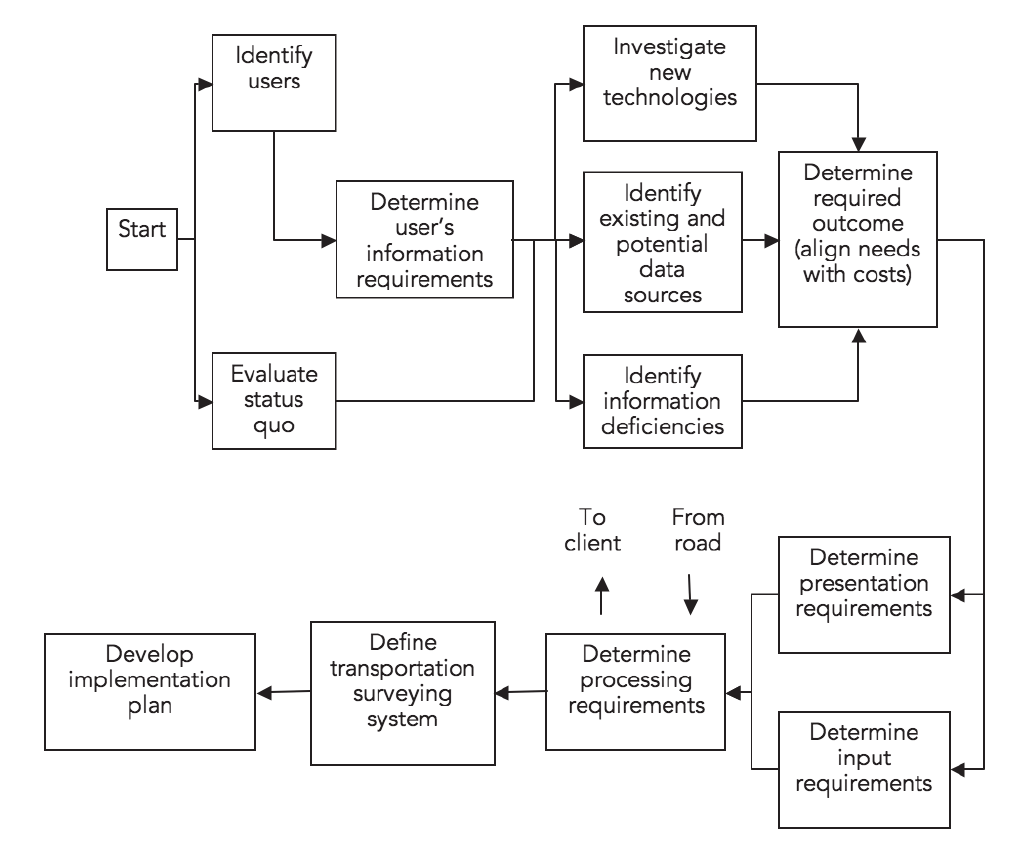
Figure 1: Logical flow diagram for defining and